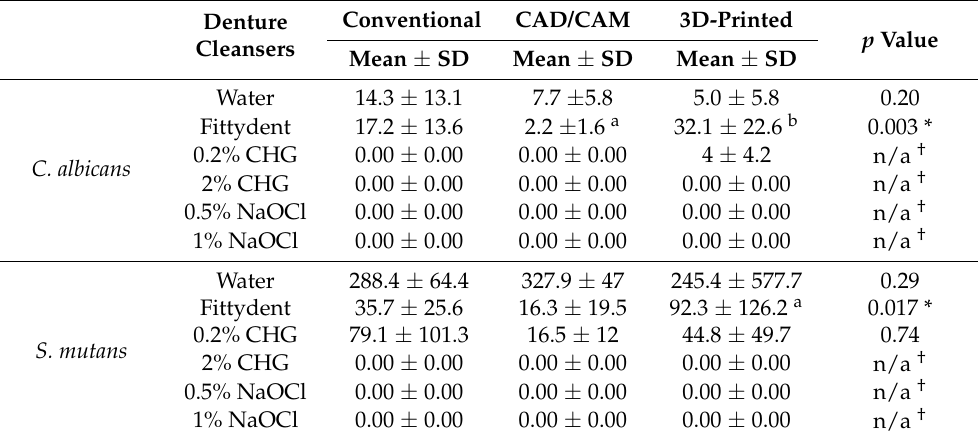
Table 2. Number (10 3 CFU/mL) of C. albicans and S. mutans after denture cleanser treatment (Mean ±